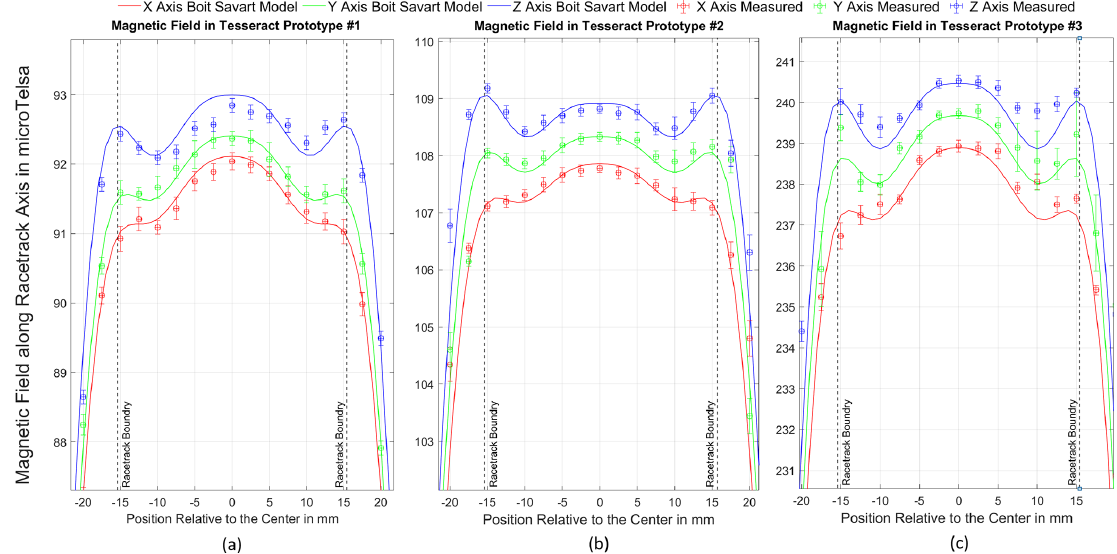
Figure 8. The measured values of the magnetic field for each position along the axis of the racetrack borehole are plotted as circles with their corresponding error bars. The output Biot–Savart simulation at the location of the racetrack core is plotted as a solid